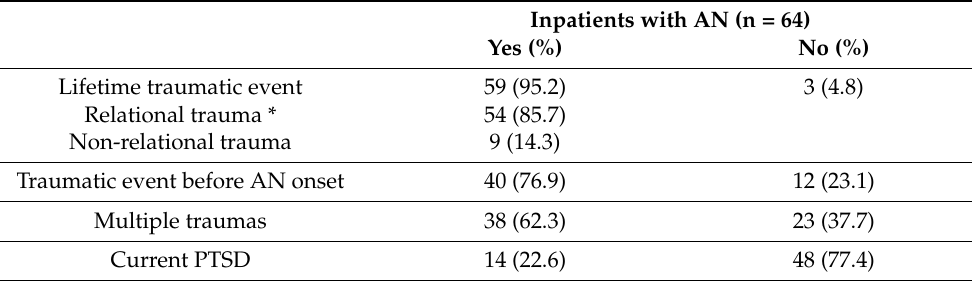
Table 3. Trauma-related risk factors in young patients with AN as measured by the Life Events Checklist (LEC) and Structured Clinical Interview for the DSM-5.